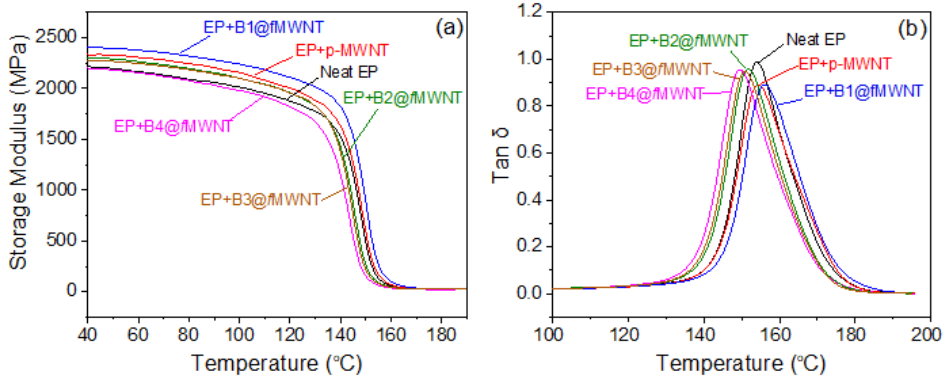
Figure 5. Storage modulus ( a ) and tan δ ( b ) of epoxy composites with 0.05 wt% of p-MWNTs and bc@MWNTs.